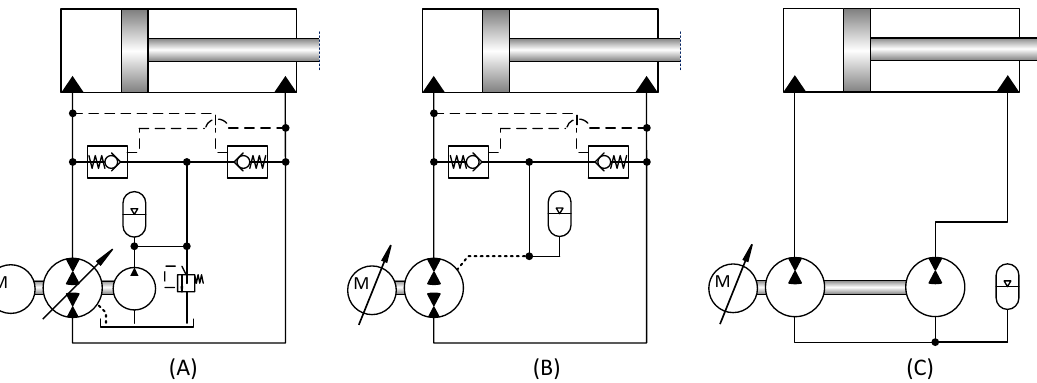
Figure 1. Examples on self-contained linear hydraulic drives. ( A ) Variable displacement, closed circuit drive. ( B ) Variable speed, closed circuit drive. ( C ) Variable speed, open circuit